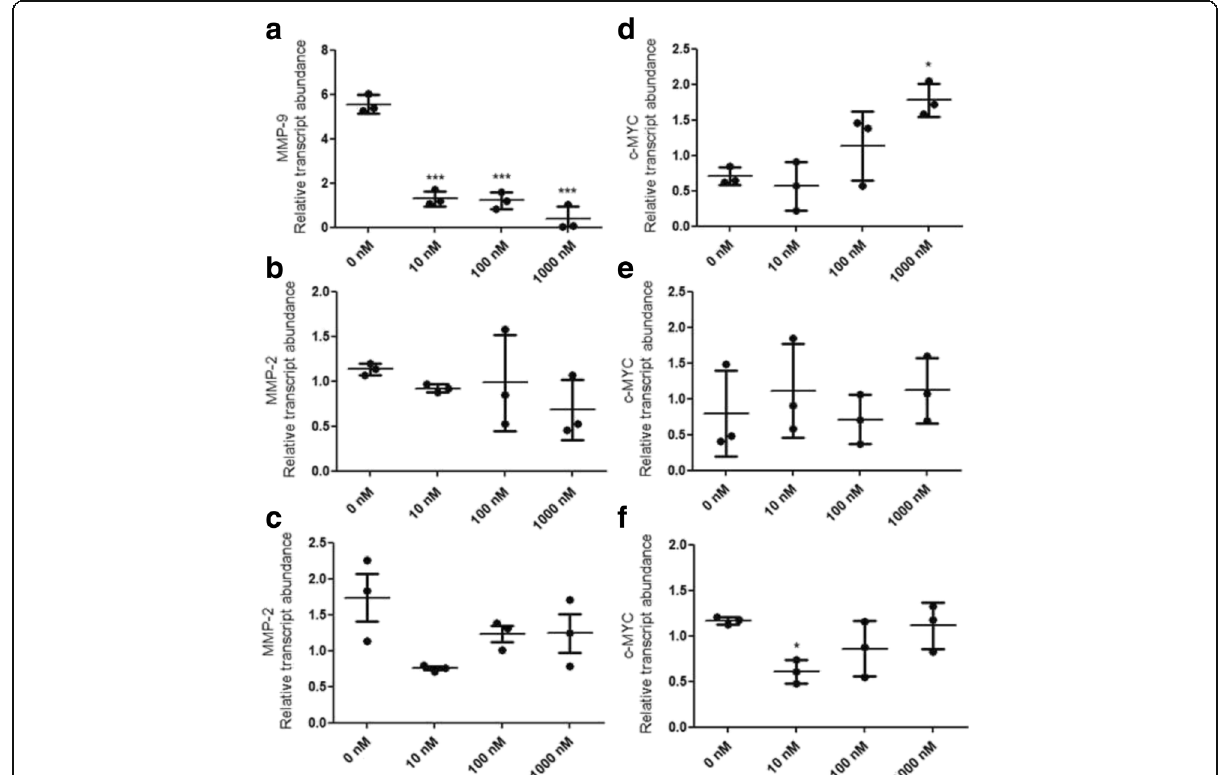
Fig. 5 ( a ) ALT-C effects on MMP-9 expression in MDA-MB-231 cells, and ( b ) on MMP-2 mRNA levels in fibroblasts or ( c ) HMEC-1 cells. Levels of c-Myc mRNA after ALT-C treatment in ( d ) MDA-MB-231 cells, ( e ) human fibroblasts, and ( f ) HMEC-1 cells. The values represent relative transcript abundance and the p value was determined using ANOVA followed by Tukey ’ s test. Values were normalized to the level of glyceraldehyde 3-phosphate dehydrogenase (GAPDH) mRNA. The assay was performed in triplicate with two independent assays ( n = 2). * p < 0.05, *** p < 0.001 compared to control (0 nM)